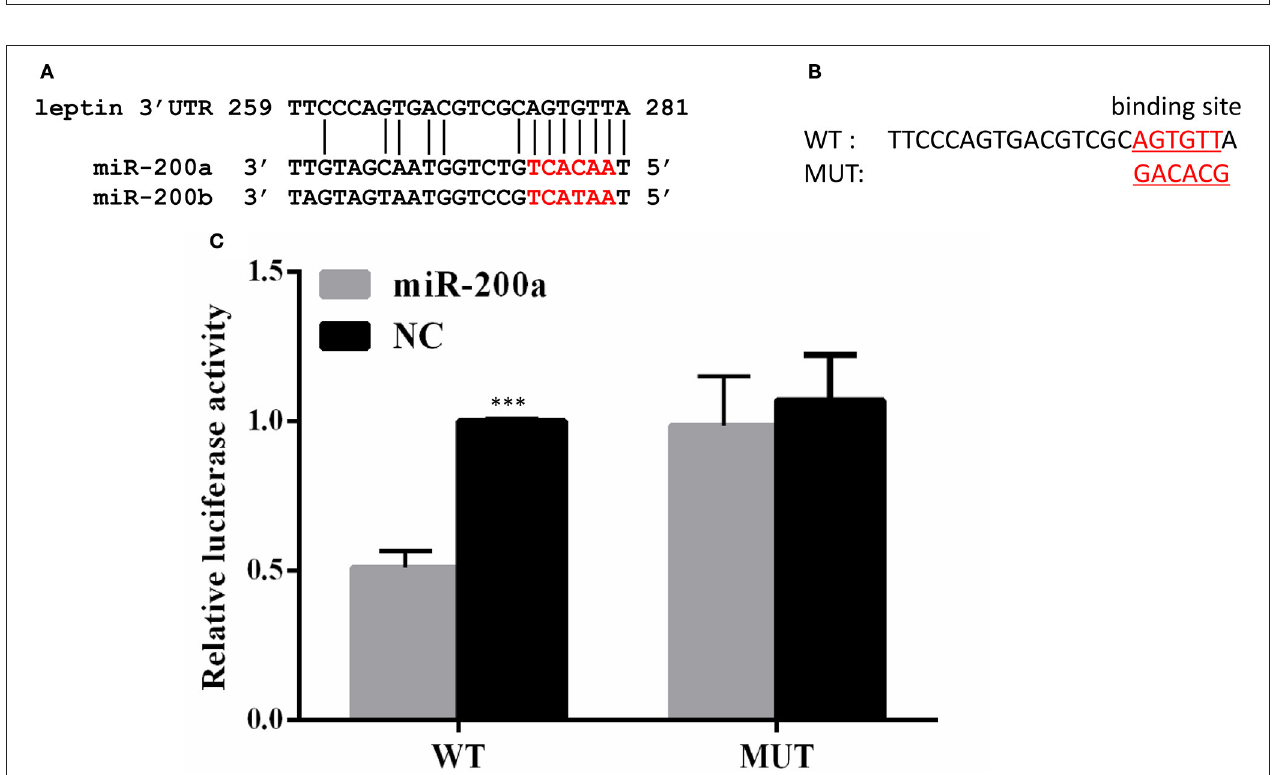
FIGURE 3 | Lep is a target of miR-200a. (A) Conserved miR-200a seeding sequence and its binding site in the leptin 3 ′ UTR are marked in red. (B) The sequence information of the putative lep 3 ′ UTR binding site in wild type (WT) and mutant (MUT) were showed. (C) miR-200a suppressed the activity of pmirGLO- lep 3 ′ UTR plasmid, but not mutant vector. The Firefly activity was normalized to Renilla expression, which was used as a control for transfection efficiency. Luciferase assays were performed in triplicate and were representative of 3 independent experiments. This experiment was carried on in Hela cell line. NC, negative control. The asterisk indicates the significant differences of gene expression between different groups (*** P < 0.001).